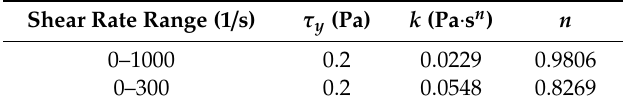
Table 1. Example of Herschel-Bulkley parameters calculated from the flow curve of a used drilling fluid at 25 ◦ C, measured using an Anton Paar Physica MCR 102